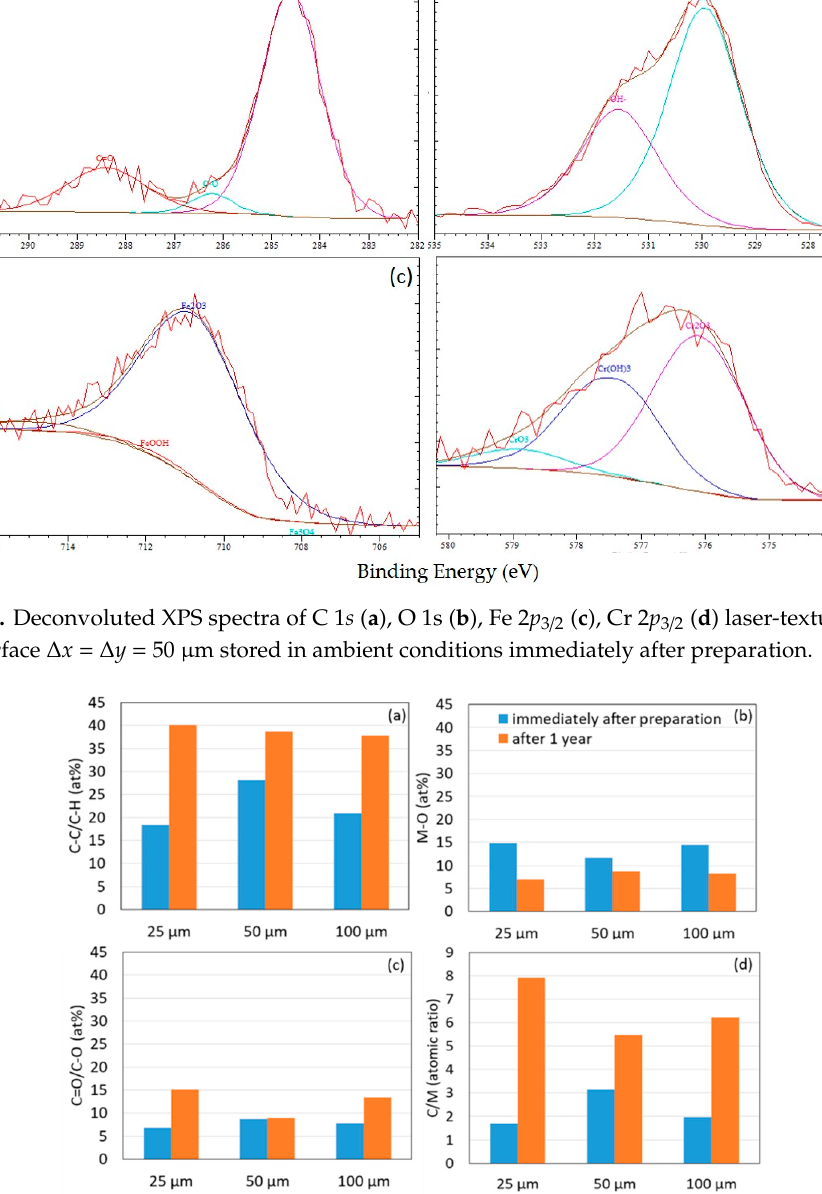
Figure 5. Relative amount of C–C/C–H functional groups (at.%) ( a ), relative amount of metal oxides M–O ( b ), relative amount of C=O/C–O ( c ), and the ratio of C/M obtained from the high-resolution XPS spectra ( d ) for laser-textured surfaces with ∆ x = ∆ y = 25, 50, and 100 μ m.